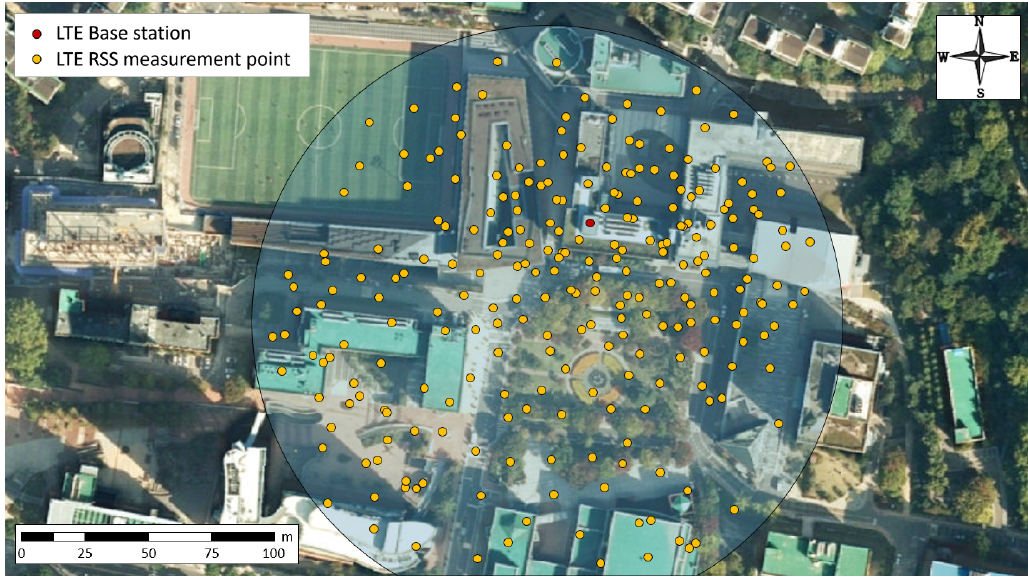
Figure 8. The RSS points in the Soongsil University campus